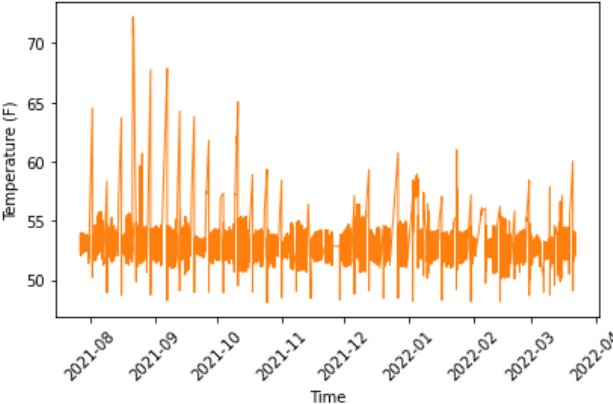
Figure A1. Chiller supply temperature in the process